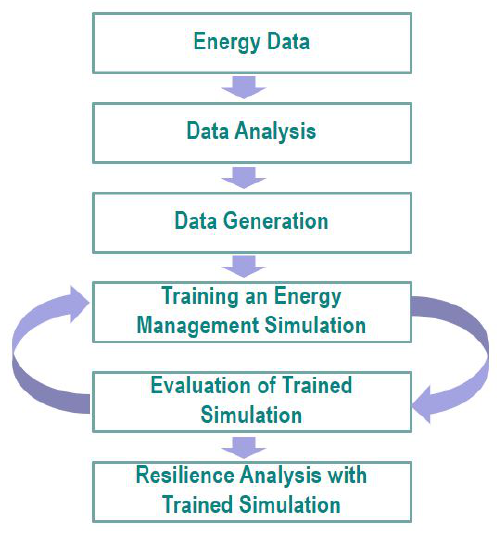
Figure 1. Proposed methodology.